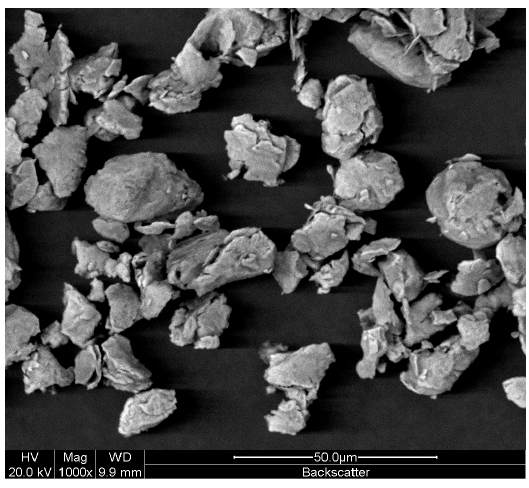
Figure 4. BSE image of dried Cr powder Table 4. Composition of Cr powder.